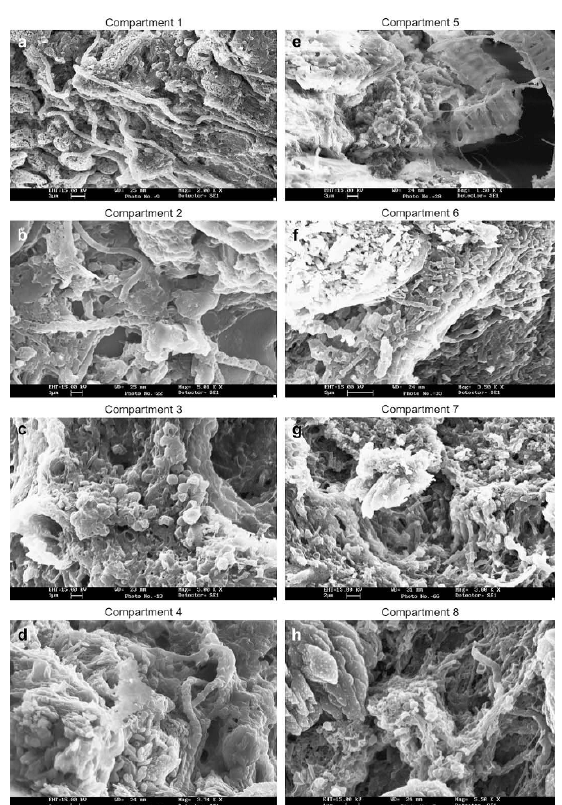
Figure 3. Different types of bacteria present